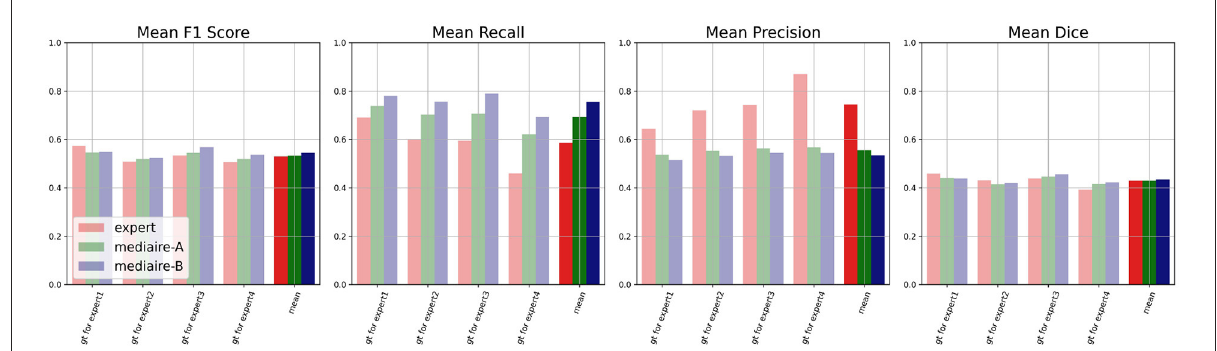
FIGURE6 Unbiased comparison of each of the experts 1, ... ,4 to segmentation pipelines mediaire-A and mediaire-B, in terms of F1 score, recall, precision, and Dice. The scores are calculated on the unbiased ground truth masks of the 32 patients in TEST-MSSEG2-NL. For every expert, this unbiased mask is constructed from the other expert masks (cf. Section 3.6) resulting in four individual comparisons with different ground truths. In the last block of each plot, we show the average score across the four experts against the average score of each pipeline across the different ground truth masks. Clearly, the segmentation pipelines have a higher recall while the experts have higher precision. In terms of F1 and Dice scores, the pipelines achieve slightly higher average results.